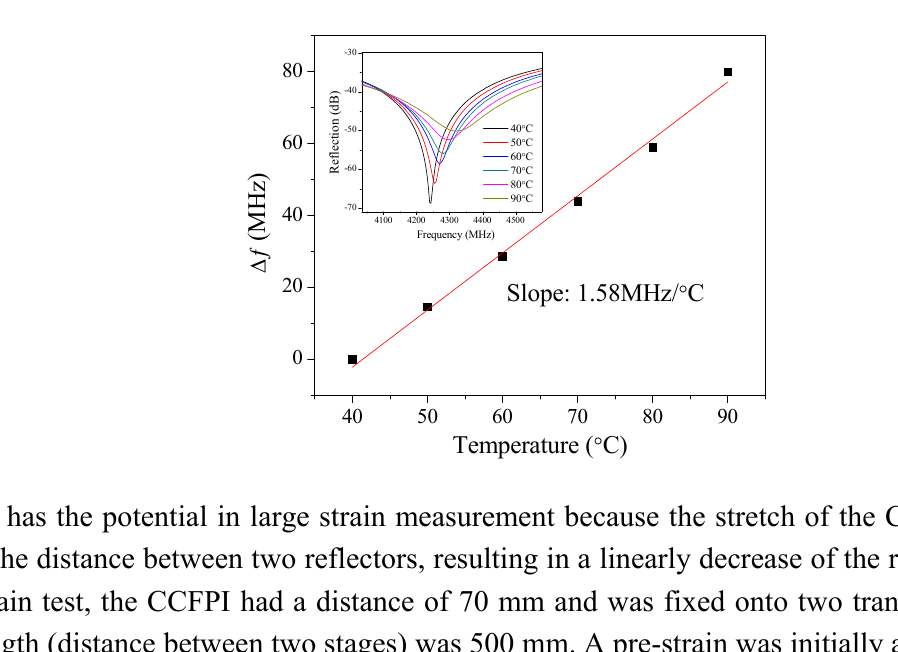
Figure 5. Resonant frequency shift as a function of ambient temperature. Inset: Shift in reflection spectra as the ambient temperature